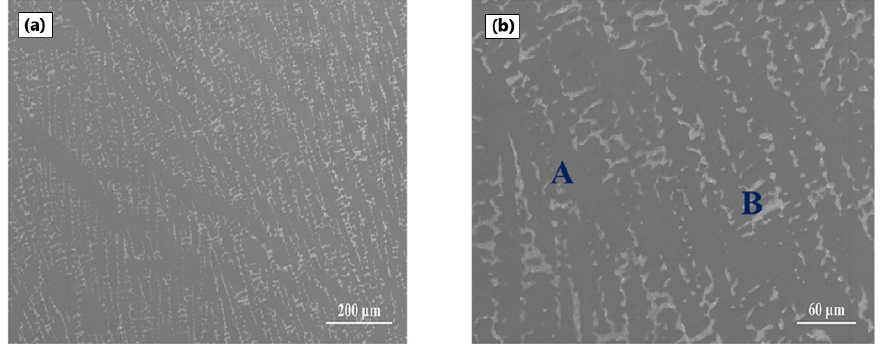
Figure 6. SEM images showing the microstructure of HEA Al 0.4 CoCrCuFeNi ( a ) melted and ( b ) after processing by HPT with dendritic and intedendritic regions (from [56]). Reprinted with permission from Elsevier: J. Mater Sci. Technol. Copyright 2022, License: 5355941102509. Seven HEAs (AgCoCrFeMnNi, CuCoCrFeMnNi, CoCrCu 2 FeMnNi, CoCrCu 3 FeMnNi, CoCrCuFeMnNiB 0.2 , CoCrCu 2 FeMnNiB 0.2 , and CoCrCu 3 FeMnNiB 0.2 ) were evaluated